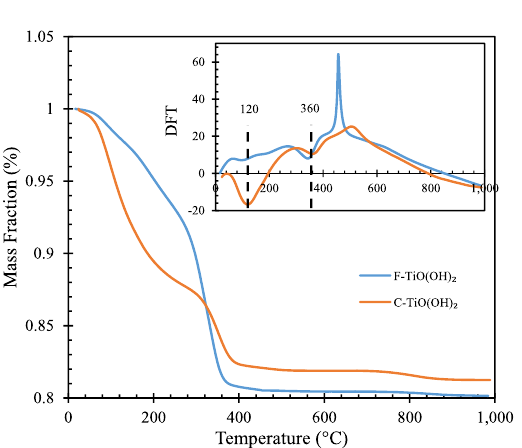
Figure 7. TGA data of F-TiO(OH) 2 and C-TiO(OH) 2 [heating rate: 20 °C/min; N 2 flow rate: 100